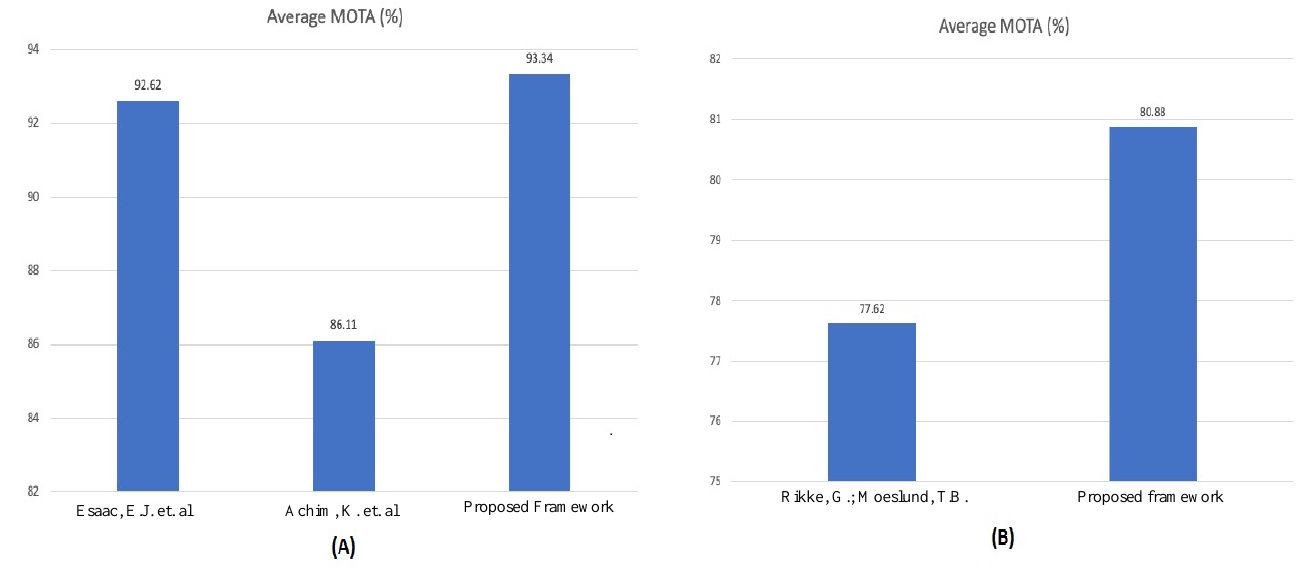
Figure 16. Comparison of the performance in terms of average MOTA %: ( A ): Comparison of the